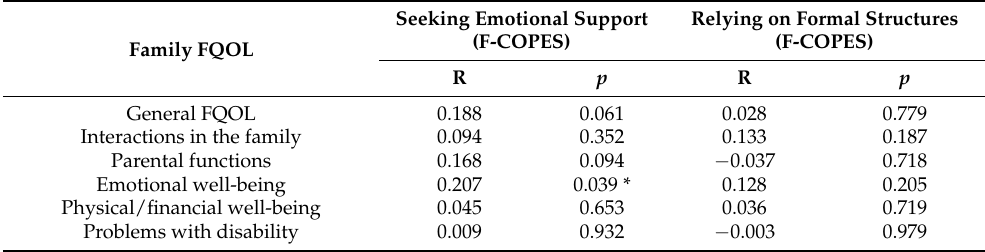
Table 7. Seeking spiritual support, relying on formal structures (F-COPES), and the level of FQOL in the assessment of children and adolescents from the control group.